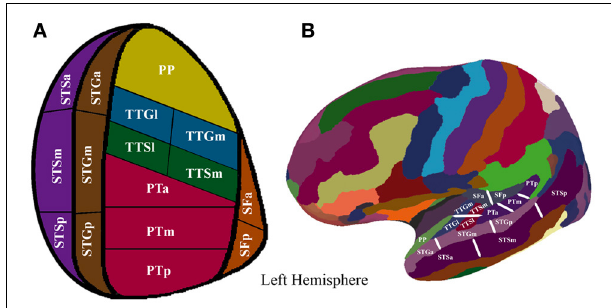
FIGURE 1 | (A) Supratemporal and STS parcellation. Anatomical parcellation of the STP and STS displayed on a flattened schematic representation of the supratemporal cortex surface. (B) Anatomical parcellation of the supratemporal plane displayed on a lateral view of a left hemisphere smoothed white matter inflated surface.